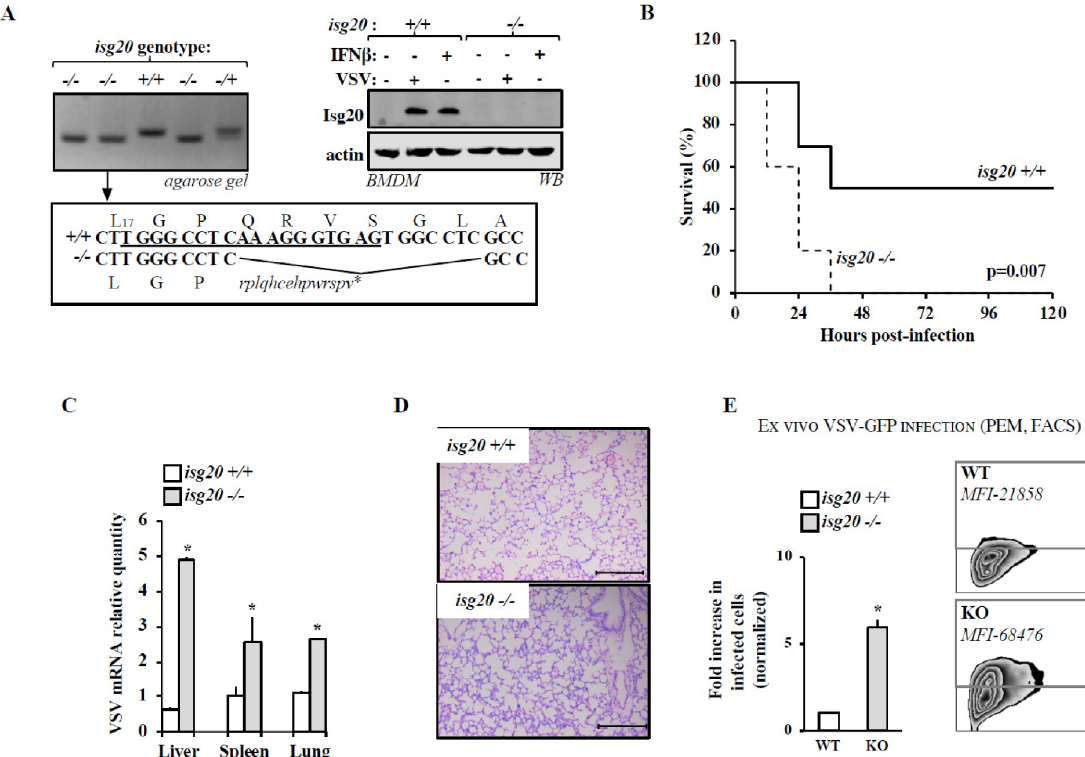
Fig 7. Isg20 -/- mice exhibit higher susceptibility to VSV infection. A) CRISPR/Cas9 was used to generate a functional ISG20 knockout mouse. The target sequence is underlined and the resulting indel mutation and downstream open reading frame, as well as corresponding PCR in founders, are shown. To detect ISG20 protein, bone marrow-derived macrophages were stimulated either with IFN β or with VSV for eight to twelve hours prior to WB analysis. B) isg20 -/- and +/+ age- and sex-matched littermates were intraperitoneally infected with VSV. The graph presents survival rates of each group. C) The extent of VSV replication in the indicated tissues was determined by RT- qPCR. D) Representative lung sections are shown upon hematoxylin and eosin staining that preferentially label inflammatory cells. E) Peritoneal macrophages (PEMs) were prepared from isg20 -/- or control mice and then challenged ex vivo with VSV-GFP (MOI 0.5) prior to flow cytometry analysis twenty-four hours later. A representative zebra plot is shown with respective MFI of GFP-positive cells. The graphs present Means and SEM of three independent experiments (20 animals in two independent experiments in survival